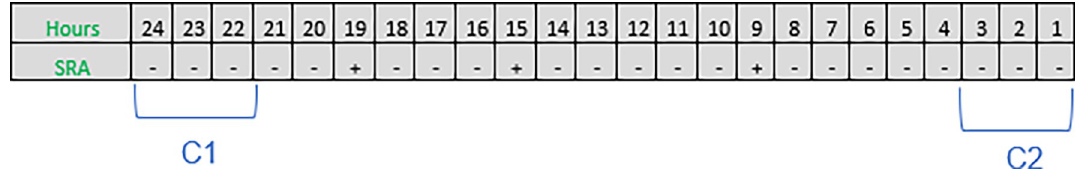
Fig 4. Example of a patient in the group II whose tracings were obtained on the second postoperative day. This patient has a greater number of negative results and only three positive results (false positives).